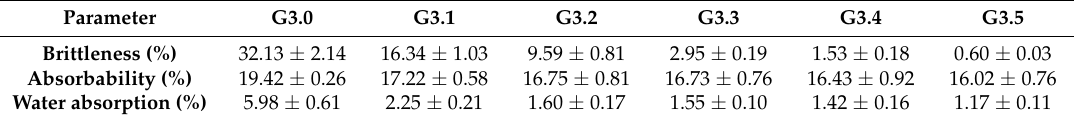
Table 6. Performance properties of PLA-RPU/PIR